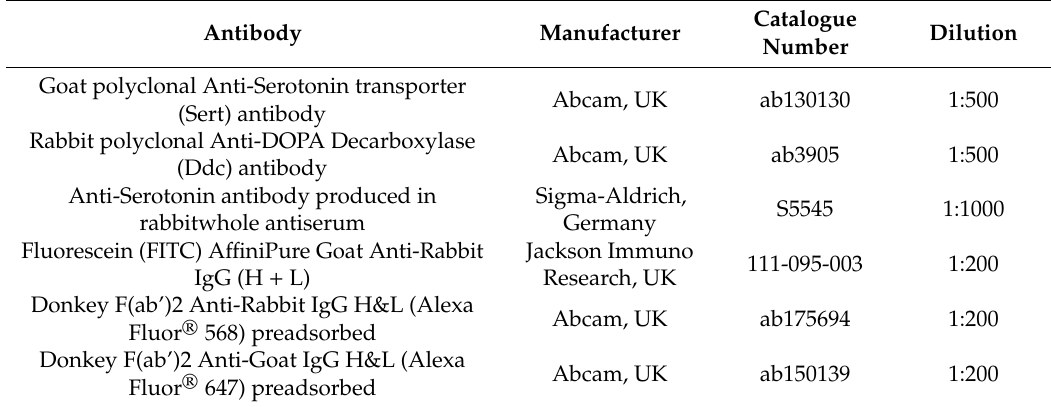
Table 2. Antibodies used for